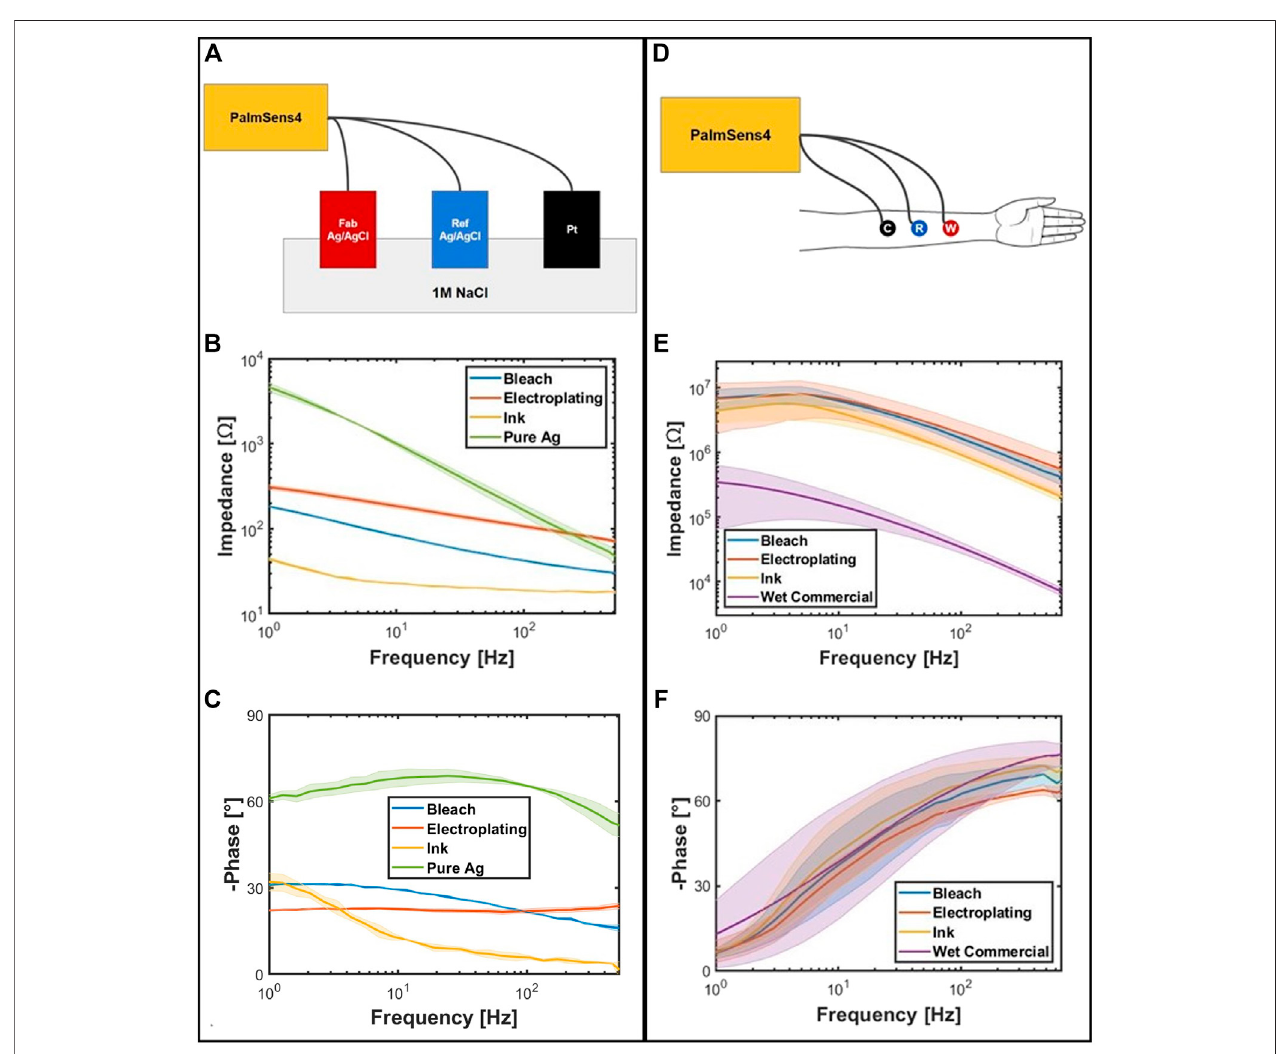
FIGURE 5 | (A) EIS setup for saline. Red is the fabricated working electrode. Blue is the Ag/AgCl aqueous reference electrode. Black is the platinum counter electrode. (B) Averageimpedancevs.frequencyoftheEISinsaline. (C) Averagenegativephasevs.frequencyoftheEISinsaline. (D) EISsetupforskin.Bulletelectrodes fabricated by the same fabrication method were used as the counter, reference, and working electrodes. (E) Average impedance vs. frequency of the EIS on skin. (F) Average negative phase vs. frequency of the EIS in skin.